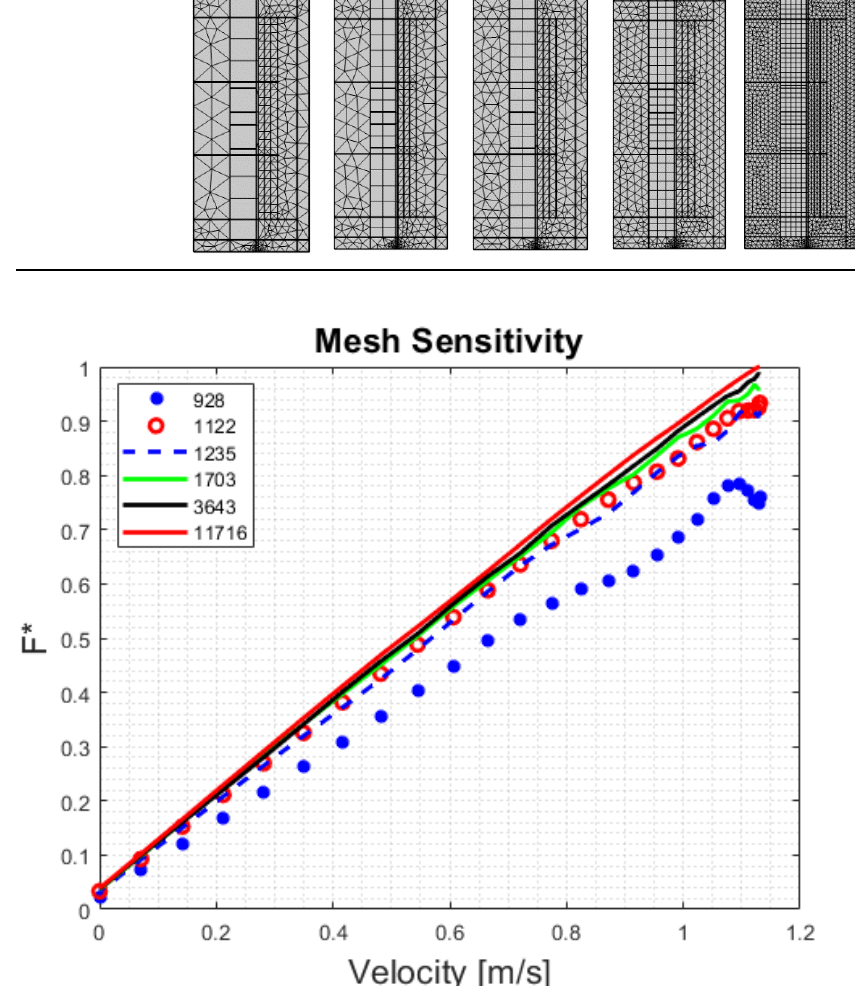
Figure 4. Mesh sensitivity to the normalized damping force vs. velocity of the piston; the number of elements is shown in the legend.